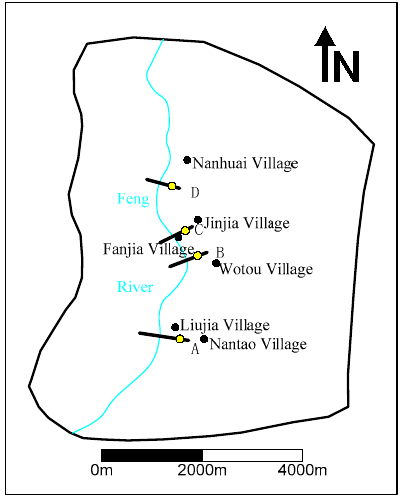
Figure 11. Positions of the four profiles.